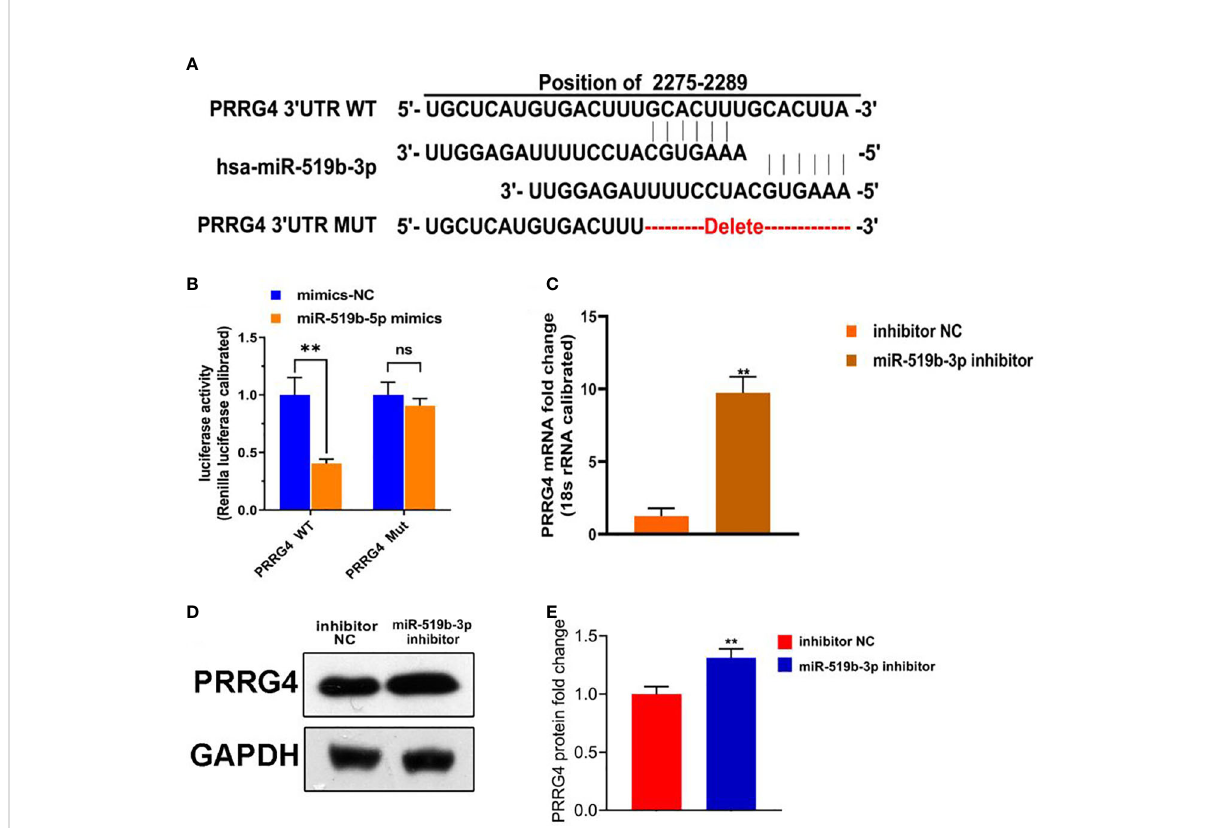
FIGURE 4 miR-519b-3p was a target gene of LncRNA HOTAIR and negatively regulated by LncRNA HOTAIR. (A) Predicted complementary sequences between miR-519b-3p and PRRG4, (B) Luciferase reporter assay con fi rmed that the luciferase activity decreased when miR-519b-3p was bound to PRRG4-wt, (C-E) mRNA and protein expression levels of PRRG4 were detected by qRT-PCR and WB. Data are presented as the mean ± SEM, n=8 in each group. **P<0.01 vs. mimics-NC or inhibitor